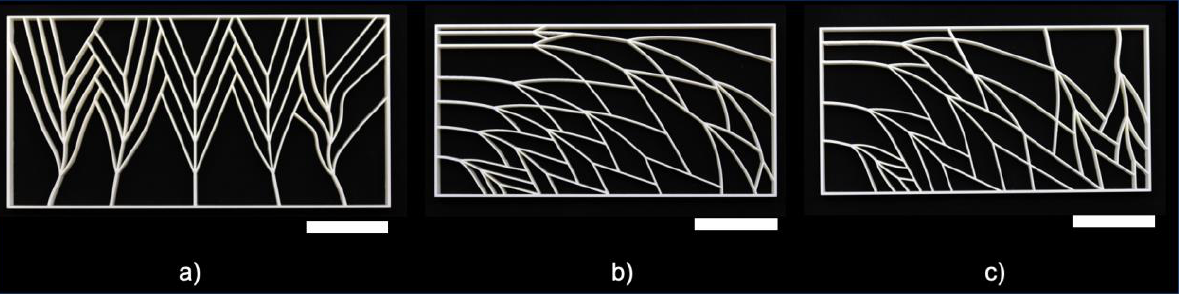
Figure 17. Structures ( a ) CL-1, ( b ) SL-2, and ( c ) CSL-1 printed with the PolyJet technique on a Stratasys Objet260 Connex3 machine with VeroWhite material. All scale bars: 50 mm.